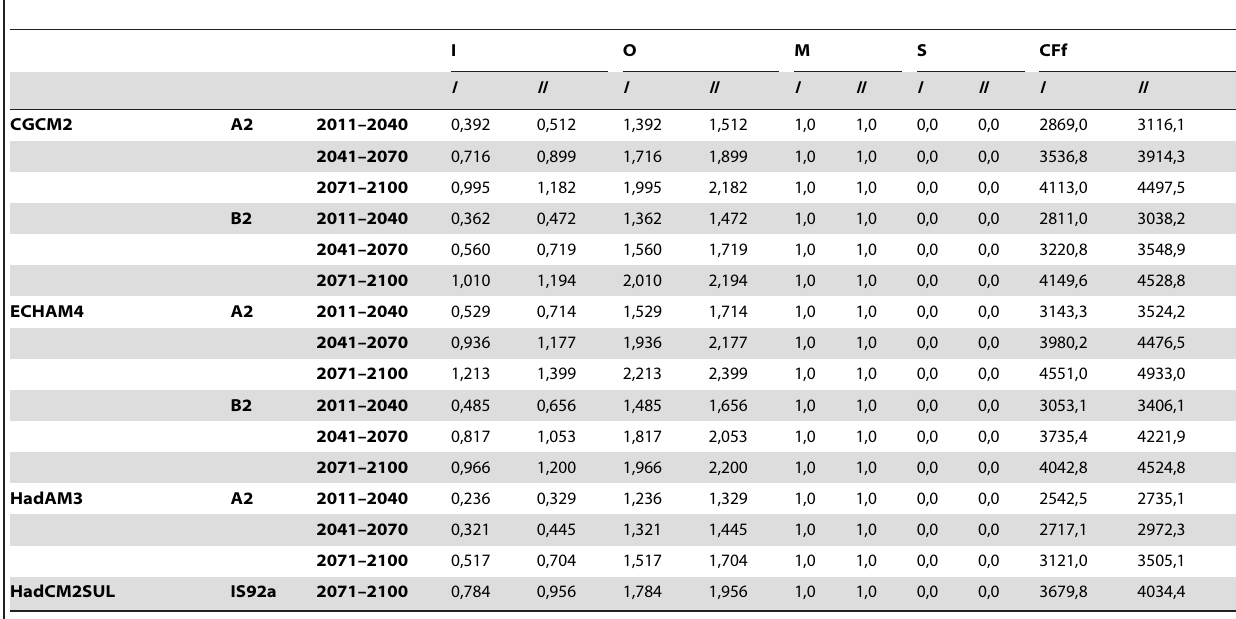
Table 5. Values of the rates of increment (I), overlap (O), maintenance (M) and shifting (S) of favourability forecasted for each future projection with respect to the 1961–1990